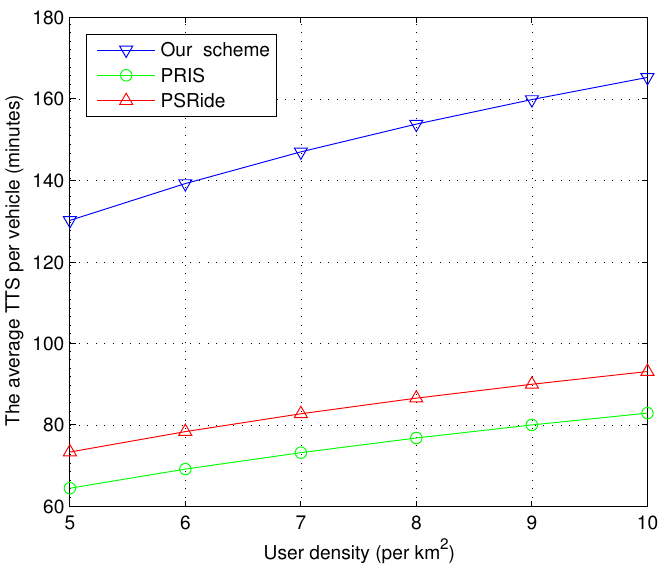
Figure 9. Impact of user density on average TTS per